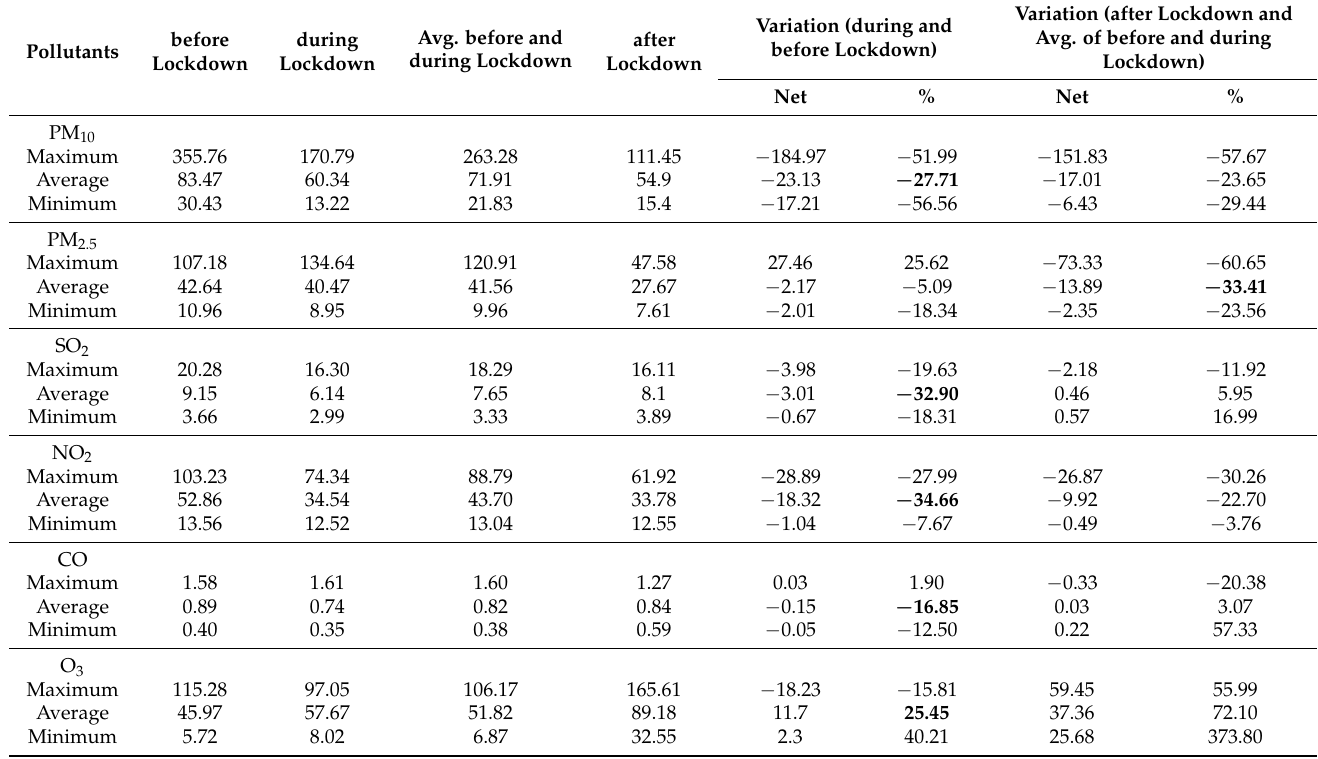
Figure 3. Daily average concentrations of PM 10 , PM 2.5 , SO 2 , NO 2 , CO and O 3 in 2017, 2018, 2019, before, during and after lockdown. Table 1. 24 h average concentration and variation of pollutants before, during and after lockdown in Nanjing. (Bold values show average maximum